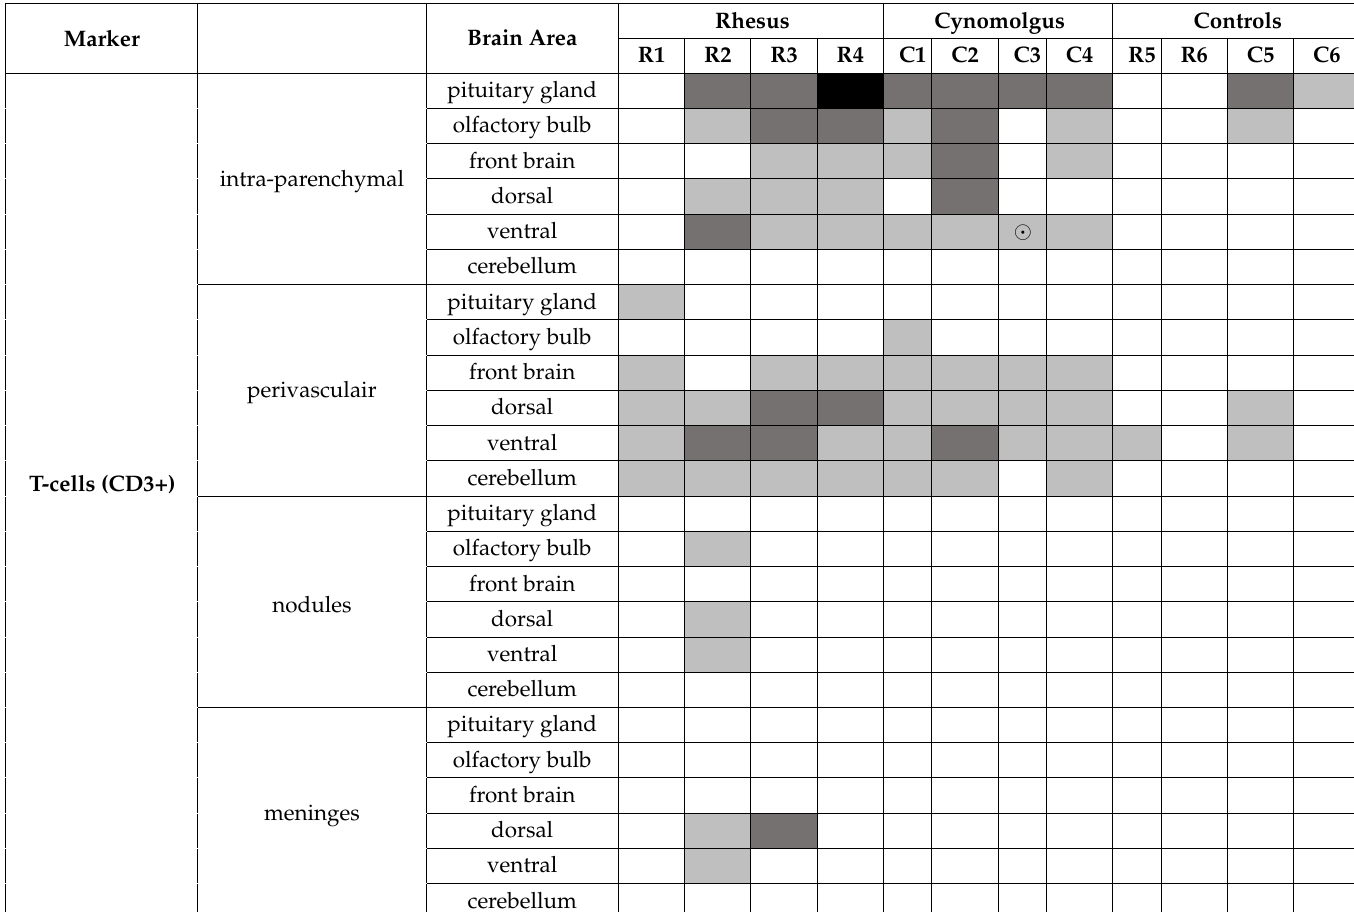
Table 2. Histological